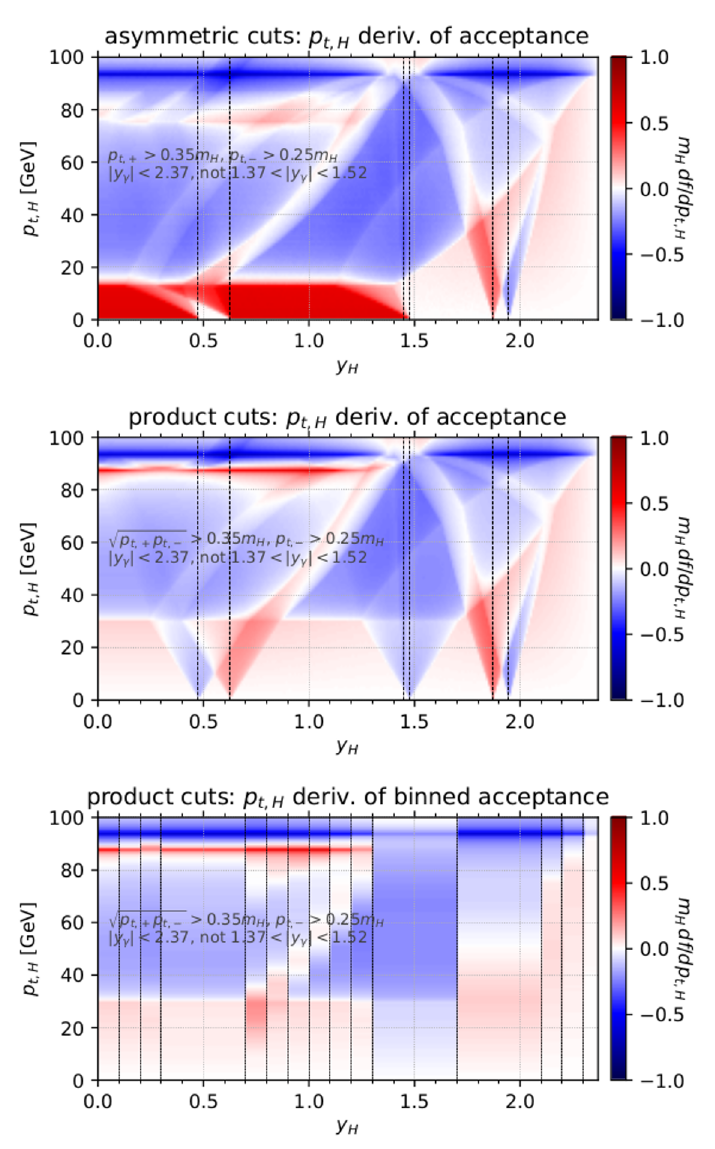
Figure 9 . The p t, h derivative of the acceptance, as a function of the Higgs boson rapidity (horizontal axis) and transverse momentum (vertical axis). Linear p t, h dependence of the acceptance at small p t, h appears as a blue or red colour that persists in the p t, h → 0 limit. The upper plot shows the results for the standard ATLAS asymmetric cuts. The middle plot shows the results obtained √ replacing the p t, + > 0 . 35 m h cut with a product cut, p t, − p t, + > 0 . 35 m h , while retaining the p t, − > 0 . 25 m h cut and all photon rapidity cuts. The lower plot shows the same results averaged over rapidity